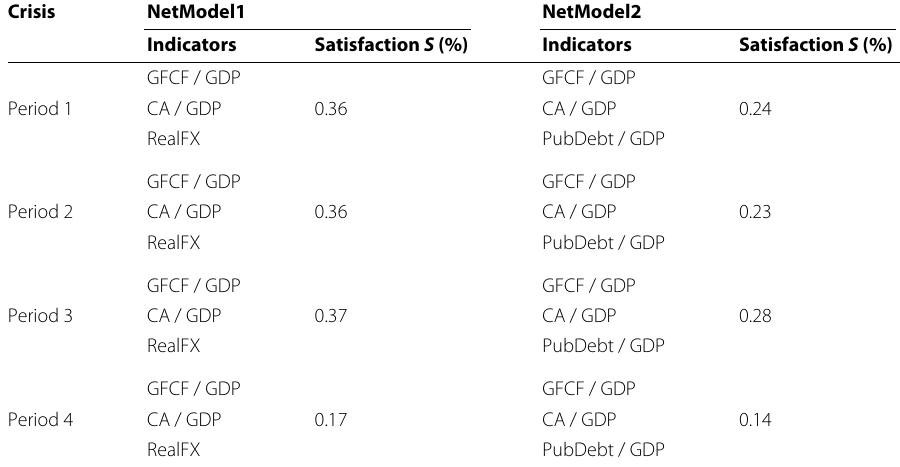
Table 5 Comparing Recurring Indicator-Bundles over Time Targeted Community-Structure : NetModel1 & NetModel2